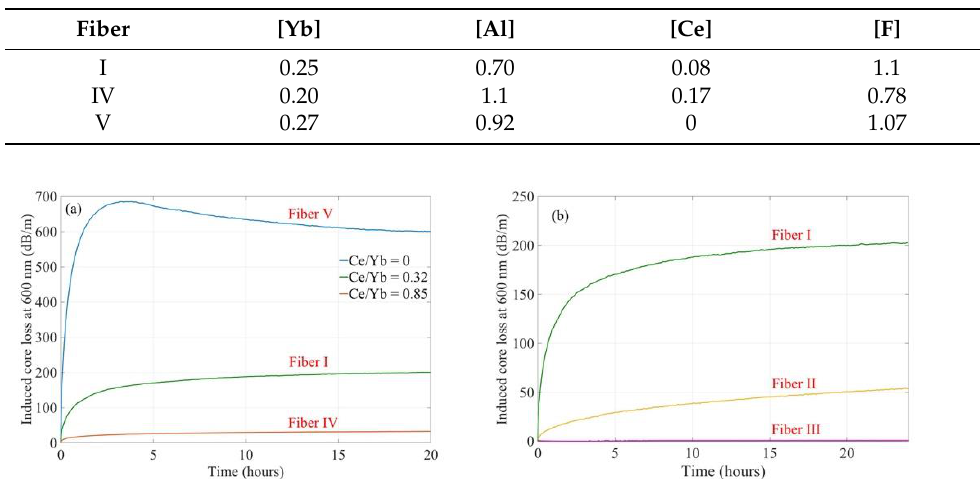
Figure 1. Core loss induced at 600 nm by photo-darkening measured ( a ) in three fibers with similar Yb concentrations but different Ce/Yb ratios (see Table 2), and ( b ) in the three fibers used in the fiber amplifiers.